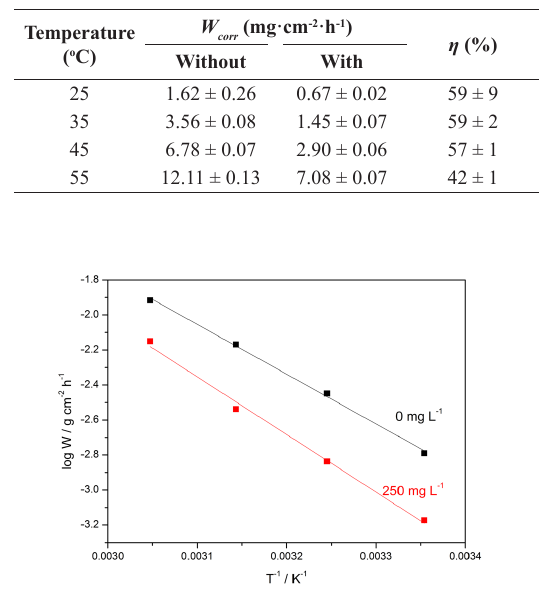
SO with and Table 5: C‑steel weight loss data in 1.0 mol L‑1 H2SO4 without 2 4 and with 250 mg L‑1 of methanolic Bauhinia purpurea extract at the following immersion temperatures: 25, 35, 45 and 55 oC with an immersion period of 2.0 hours.